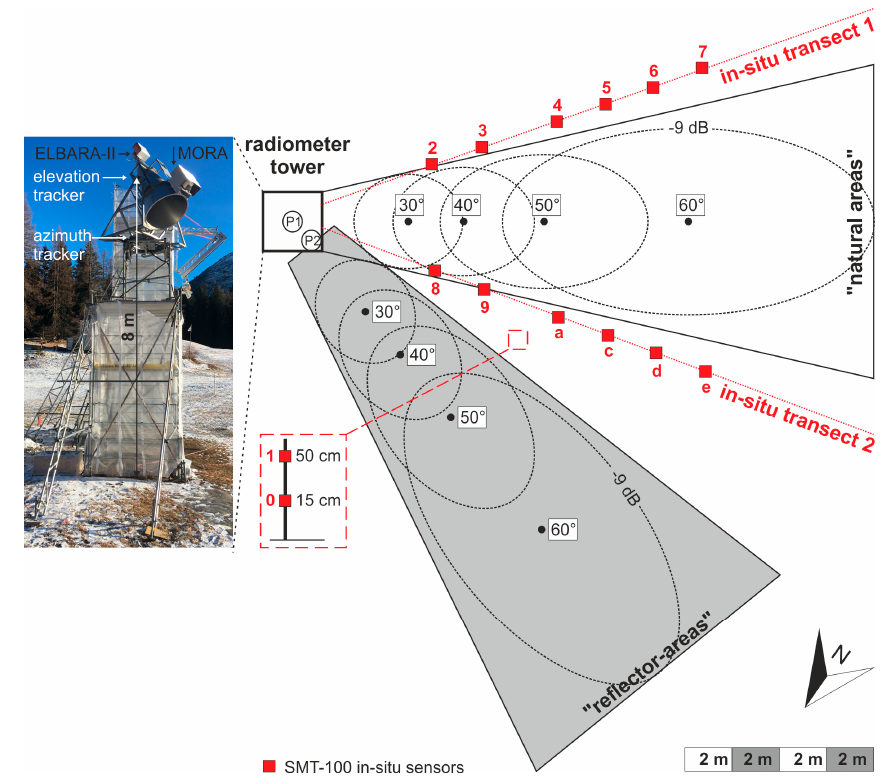
Figure 1. Schematics of the footprint areas and the location of the in-situ sensors. ELBARA-II was initially installed at the center (position P1) of the upper-most platform of the tower. The radiometer scaffold was moved to position P2 (bottom right corner of the tower) on 12 December 2016 for RFI improvement.